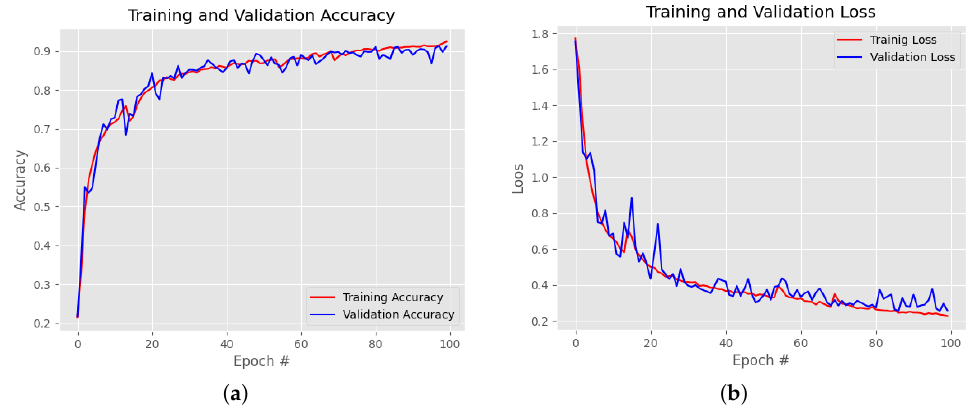
Figure 10. Results from training the CNN using 224 × 224 images. ( a ) Accuracy graph. ( b ) Loss graph.